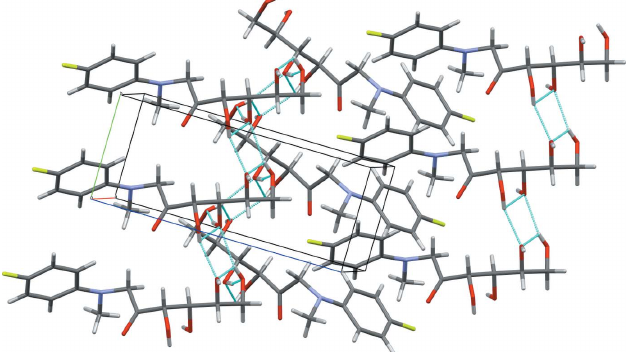
Symmetry codes: (i) x , y + 1, z ; (ii) (cid:5) x , y + 1 2 , (cid:5) z .